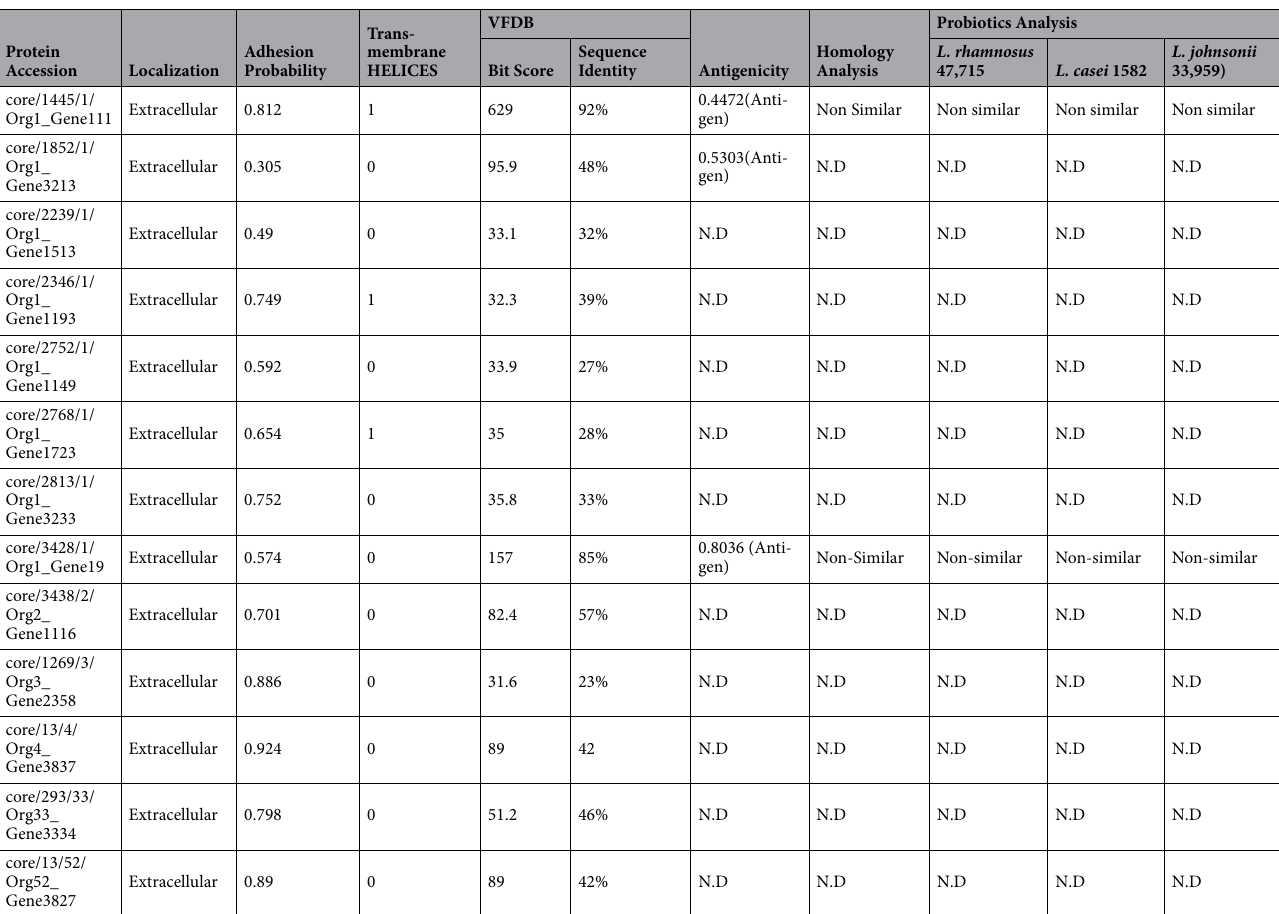
Table 1. Different properties of filtered exo-proteome and secretome of the M. tuberculosis helped in identify potential candidates for epitope mapping. If a protein fails in one of the given analysis that protein was not forwarded to the next analysis. N.D not